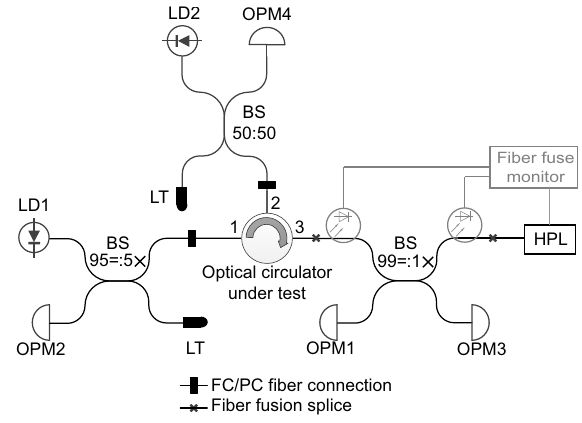
FIG. 2. Experimental setup for testing